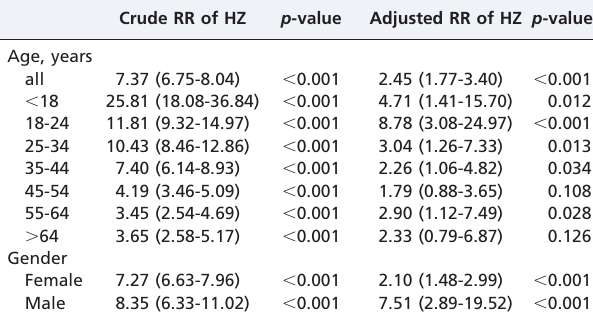
Table 5 - Crude and multivariate adjusted risk ratios (RRs) with 95% confidence intervals for herpes zoster in the SLE patients and non-SLE controls, as stratified by age and gender, during the three-year follow-up period.